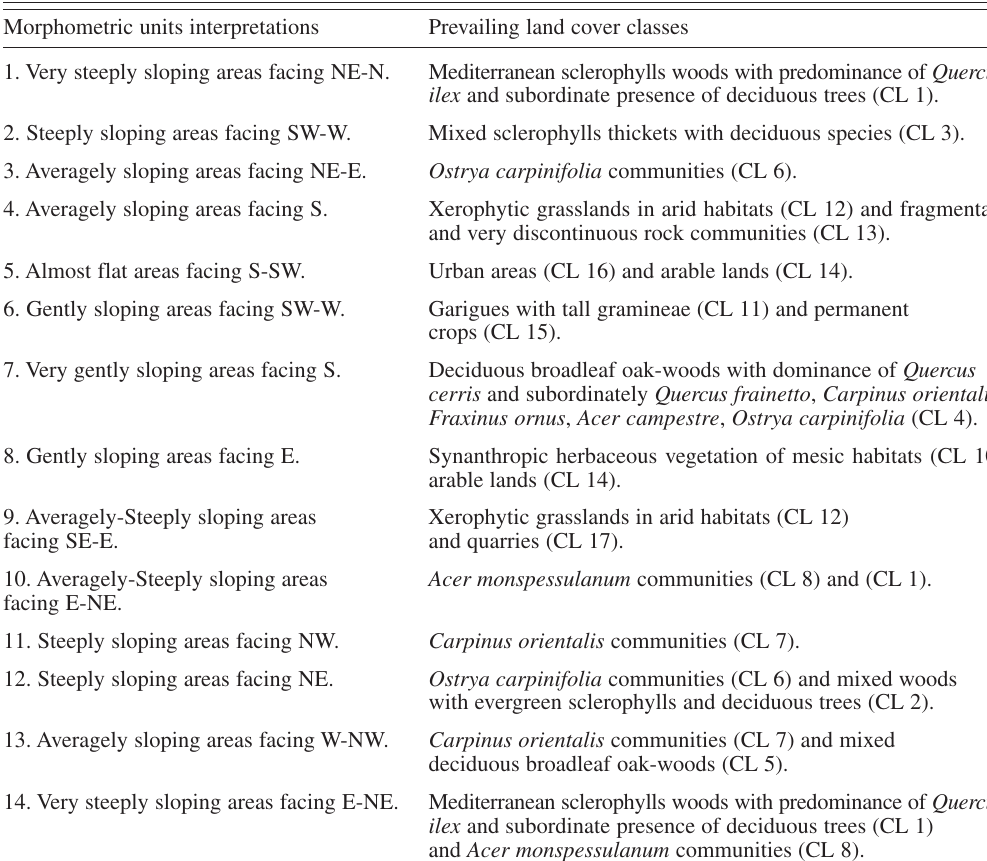
Table V. The dominance land cover types in each and all morphological units. Morphometric units